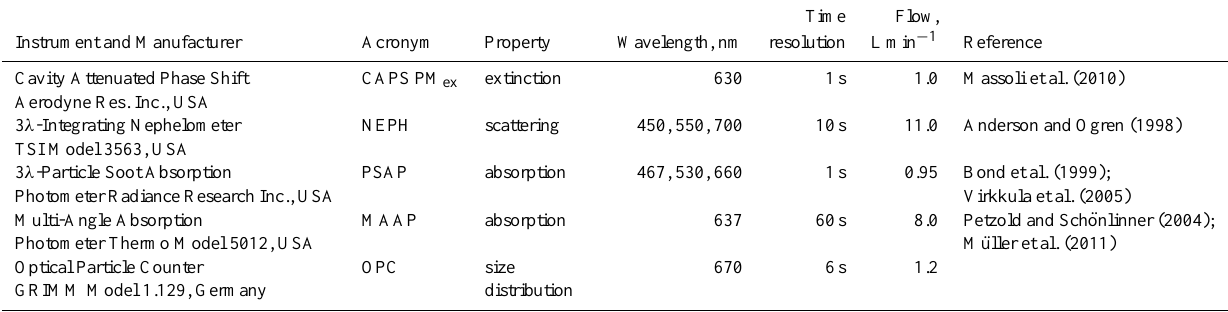
Figure 1. Experimental set-up for the pathlength adjustment of the CAPS PM ex with monodisperse PSL spheres.